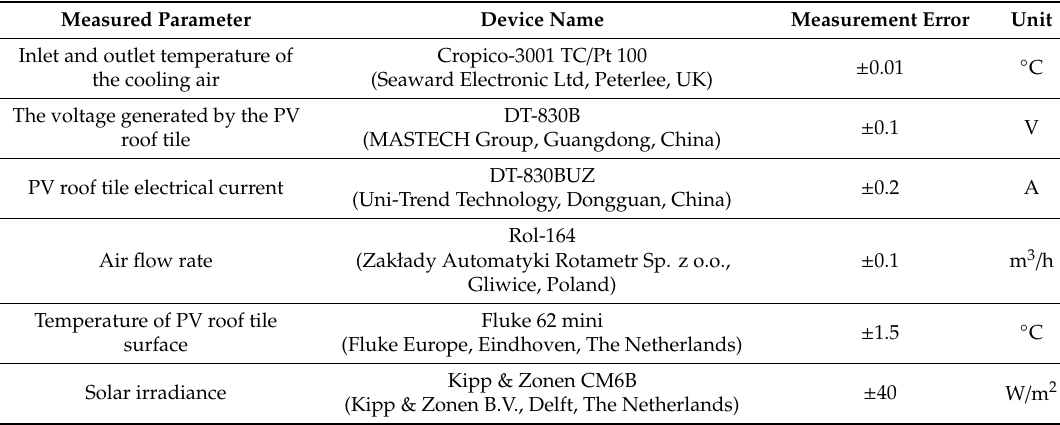
Table 3. Measuring